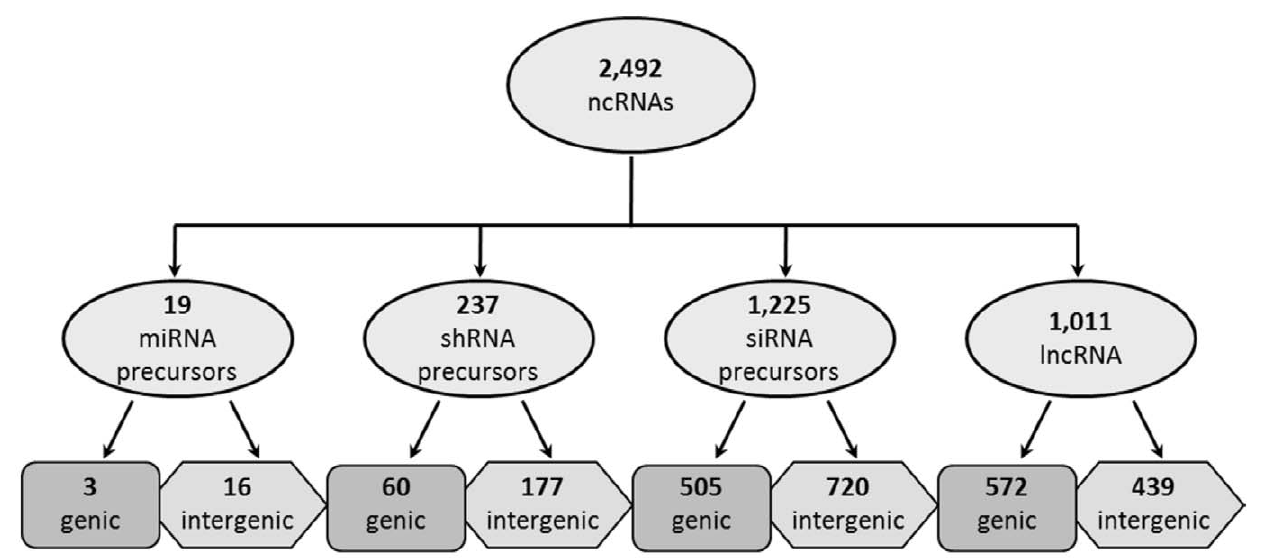
Figure 4. Results of genic vs. intergenic localization. Each subgroup of ncRNA was localized to either a genic or intergenic region in the maize genome. The number of genic and intergenic transcripts for each class of ncRNA are indicated.